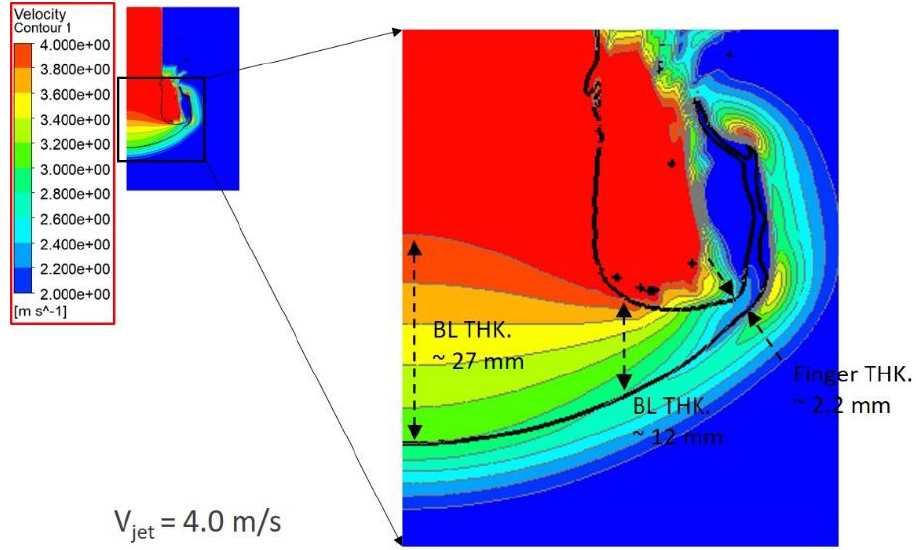
Figure 14. Velocity field and boundary layer thickness at jet leading